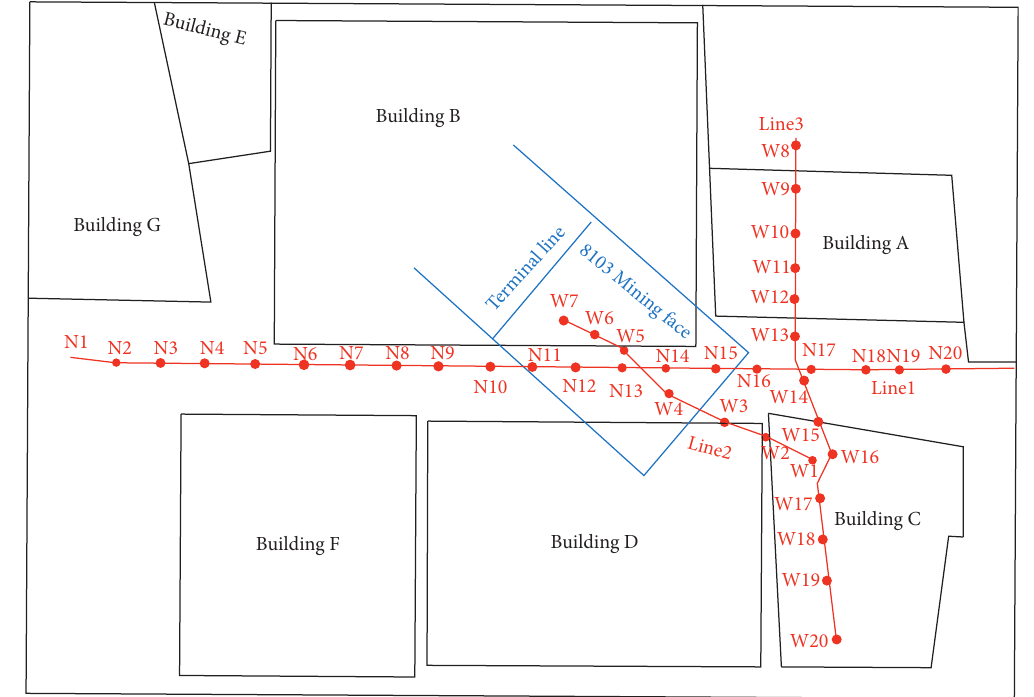
Figure 17: Layout of surface subsidence observation station in 8103 working face.